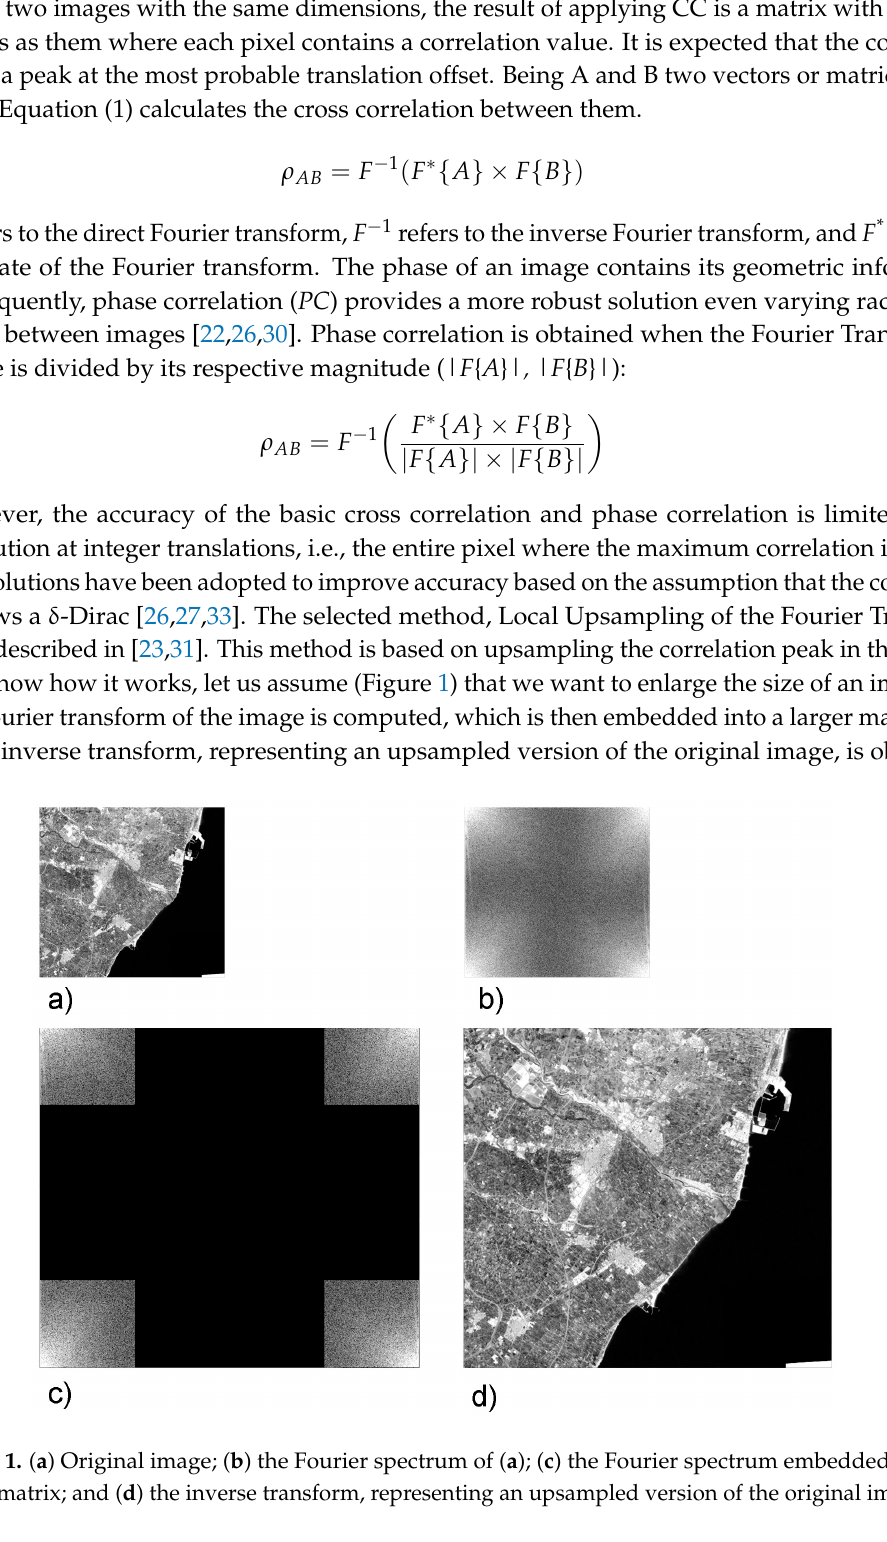
of Equation (2) (see Equation (3)) is